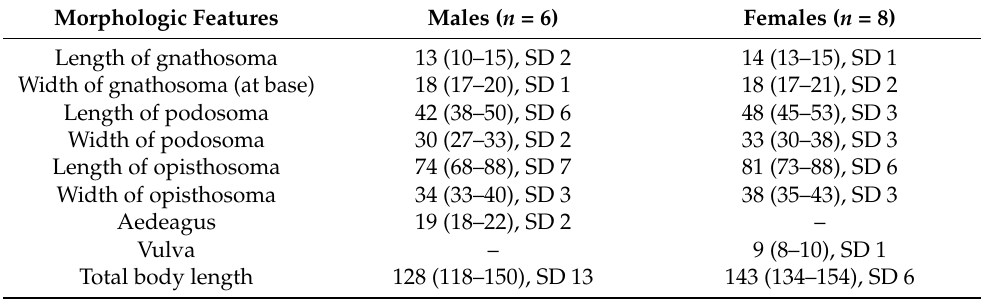
Table 2. Measurements of morphological features (in micrometers) for adults of Demodex talpae